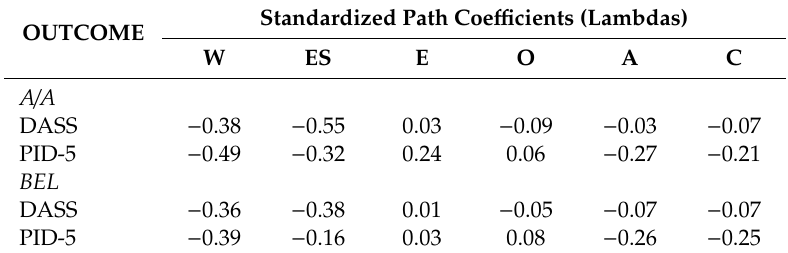
Table 7. Standardized Loadings (Lambdas) for the Numinous and Personality Constructs on the DASS and PID-5 from Model